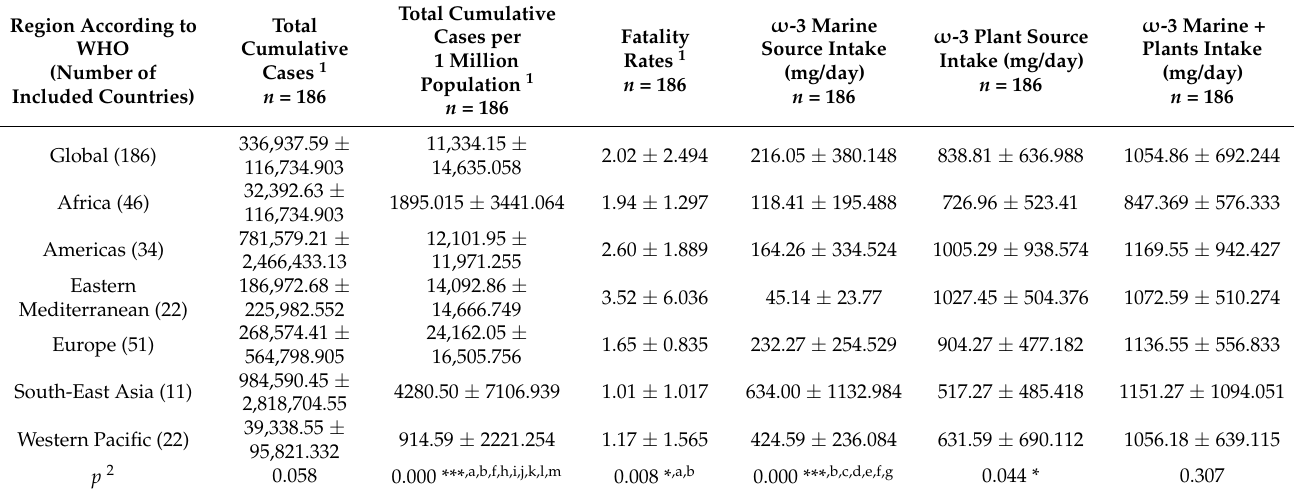
Table 1. Epidemiological data of COVID-19 and estimated ω -3 PUFA intake: comparison among regions worldwide. Region According to WHO (Number of Included Countries)